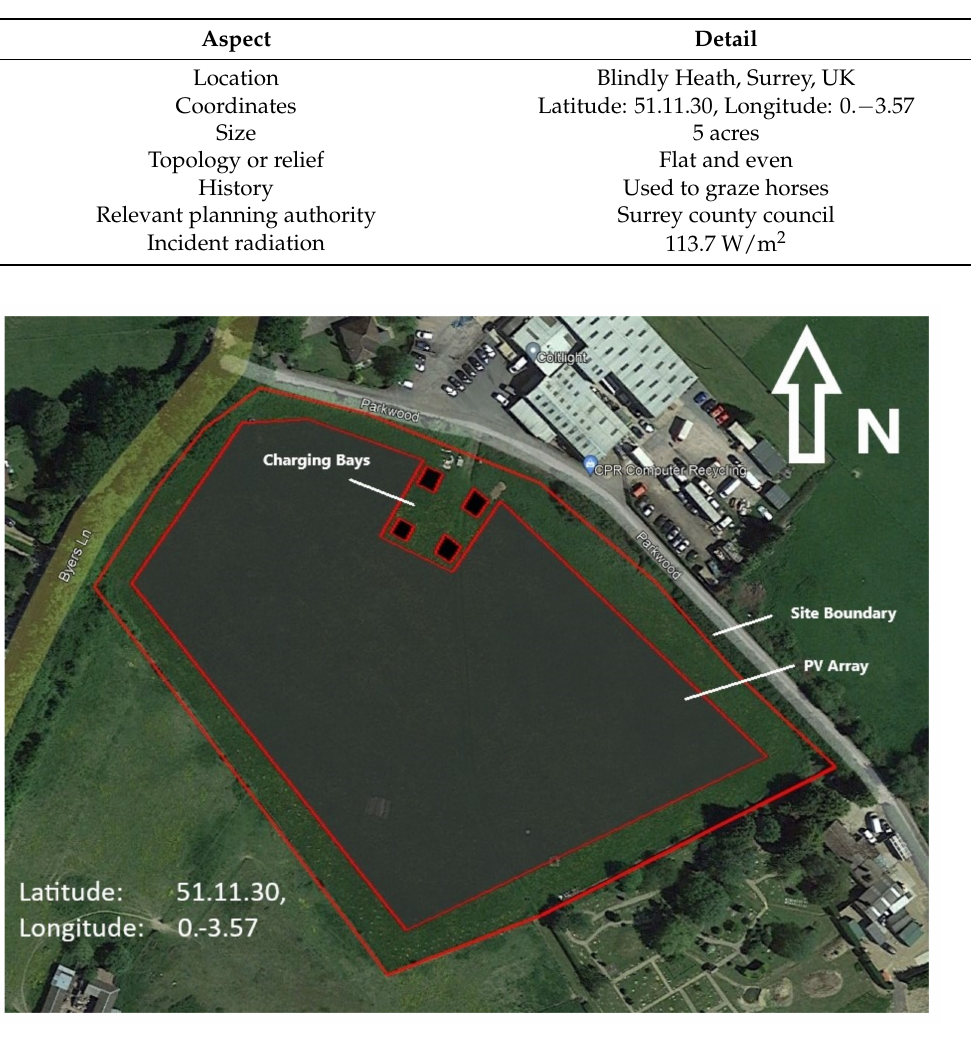
Figure 2. The PVEVCS layout and site diagram, as seen using Google Earth